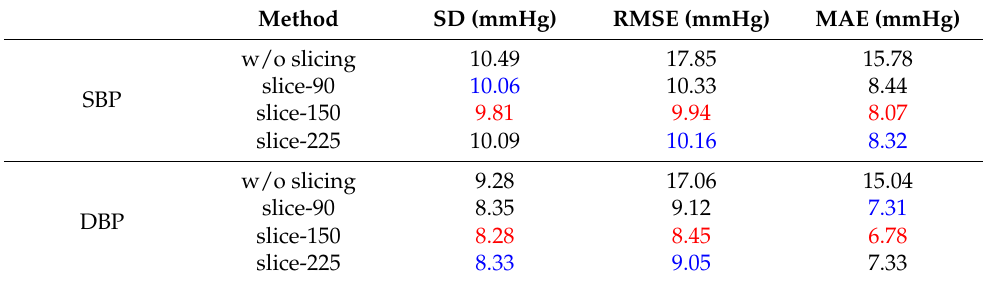
Table 2. Comparison of the performance of different clip